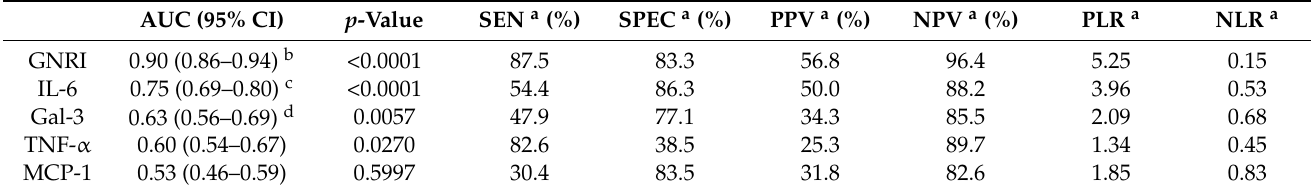
Table 3. Receiver operating characteristic curve analyses of the diagnostic performance of inflammatory and nutritional markers in identifying the presence of PEW in maintenance hemodialysis patients.